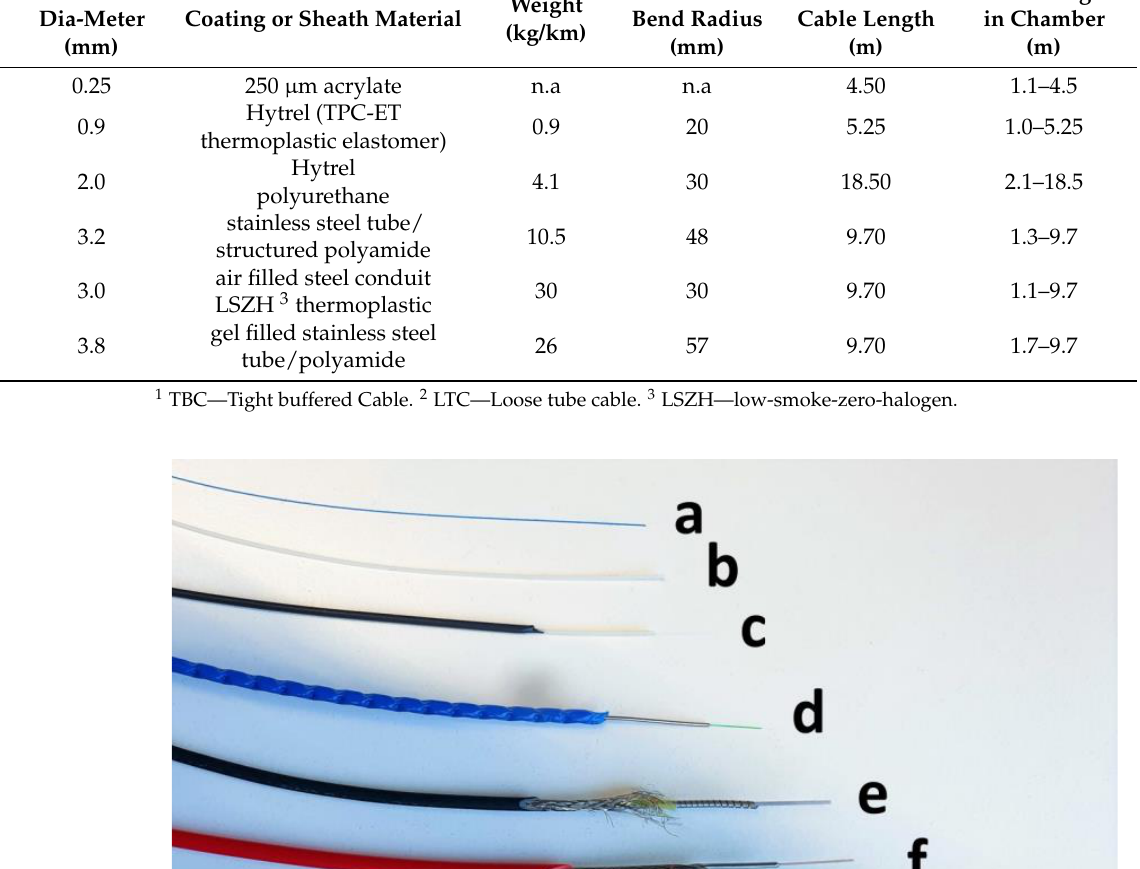
ribbed tight buffered, (e) 3.0 mm air filled loose tube cable (f) 3.8 mm gel filled loose tube cable.